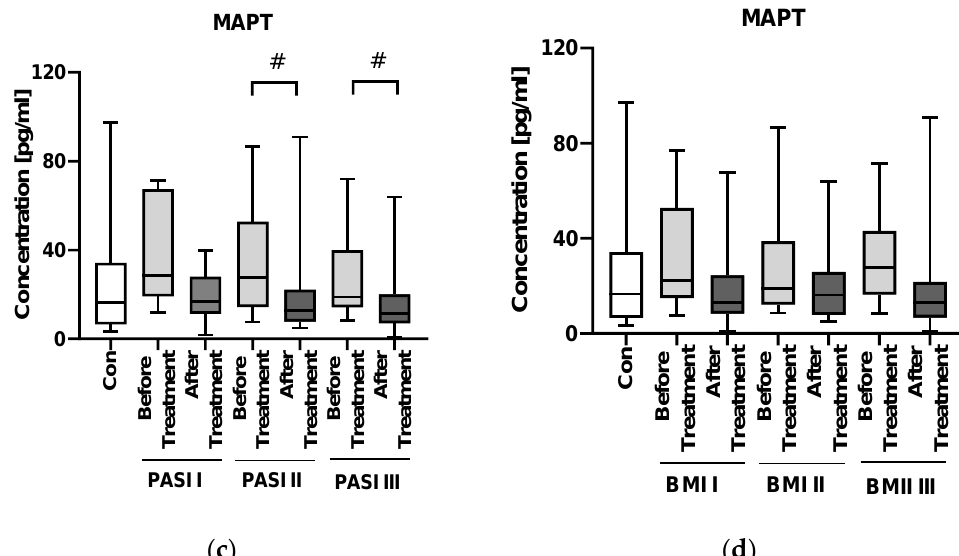
Figure 1. The levels of MAPT in psoriatics before and after total treatment ( a ), both drugs separately ( b ) and with regard to PASI ( c ) and BMI ( d ) subdivision compared to controls. * means the existence of statistically significant difference between patients single group compared to controls with p < 0.05; #/## means the existence of statistically significant difference between patients before and after the treatment with p < 0.05/<0.01.